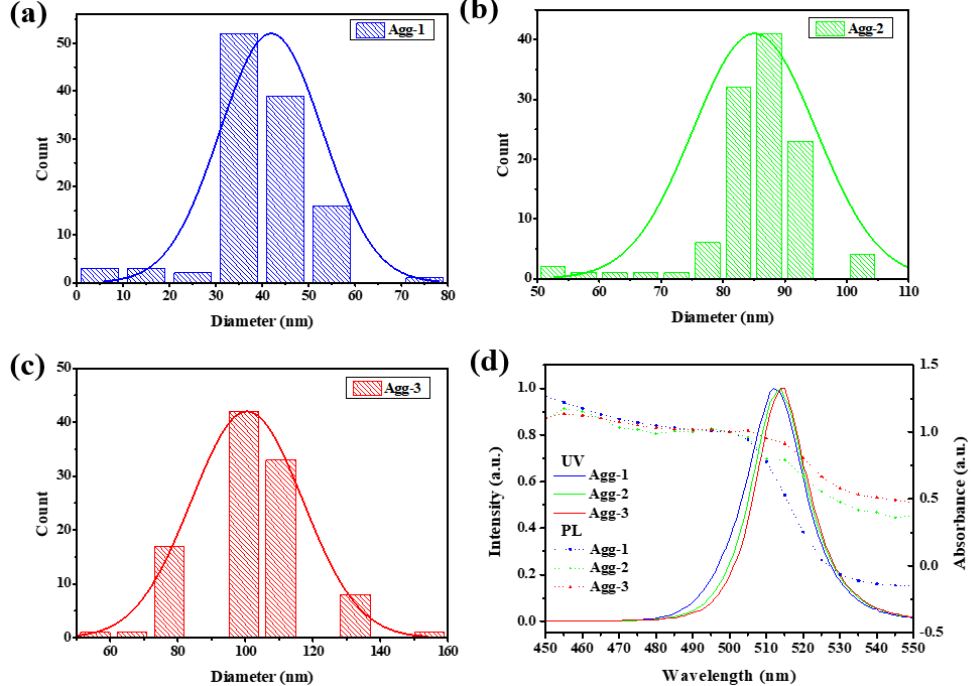
Figure 5. Particle size distributions of ( a ) Agg-1 ( b ) Agg-2, and ( c ) Agg-3 samples. ( d ) UV–Vis absorbance and emission spectra of Agg-1 (blue line), Agg-2 (green line), and Agg-3 (red line) samples.